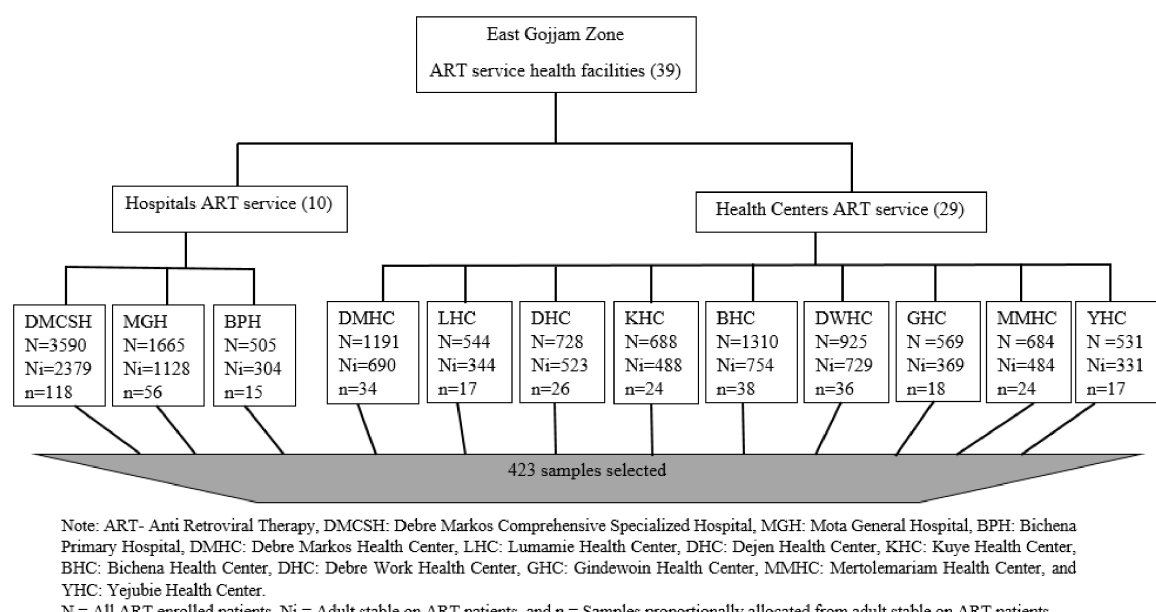
Fig 1. Schematic presentation of sampling procedures for uptake of ASM among stable clients on antiretroviral therapy in East Gojjam Zone, Amhara, Northwest Ethiopia, 2020. Note: ART-Anti Retroviral Therapy, DMCSH: Debre Markos Comprehensive Specialized Hospital, BPH: Bichena Primary Hospital, DMHC: Debre Markos Health Center, LHC: Lumamie Health Center, DHC: Dejen Health Center, KHC: Kuye Health Center, BHC: Bichena Health Center, DHC: Debre Health Center, GHC: Gindewoin Health Center, MMHC: Mertolemariam Health Center, and YHC: Yejubie Health Center. N = All ART enrolled patients, Ni = Adult stable on ART patient, and n = Samples proportionally allocated from adult stable on ART patients.